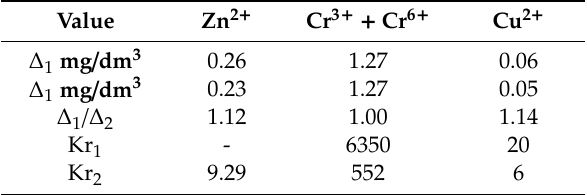
Table 3. Comparison of purification results with changing the specific processing energy.